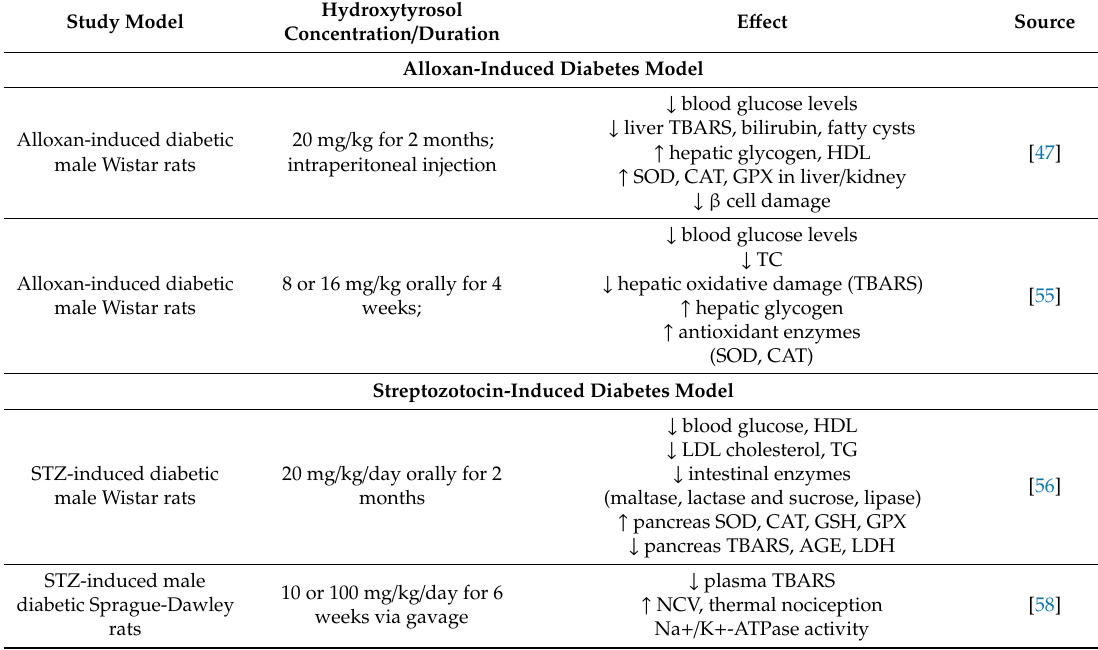
Table 7. Anti-diabetic E ff ects of Hydroxytyrosol: In vivo alloxan, streptozotocin- and genetic-induced diabetes animal